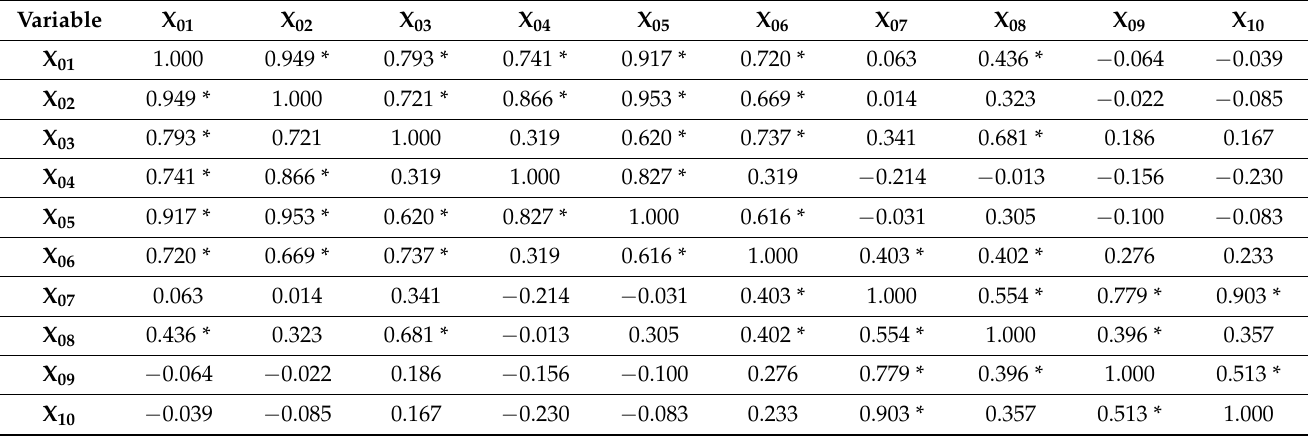
Table 5. Correlations r xy between variables characterising primary and final energy consumption in total and by individual sectors of the economy (X 01 , X 02 , X 03 , X 04 , X 05 , X 06 ) as well as the share of renewable energy in final energy consumption in total and by sector (X 07 , X 08 , X 08 , X 10 ) in EU (27) countries in 2019. Variable X 01 X